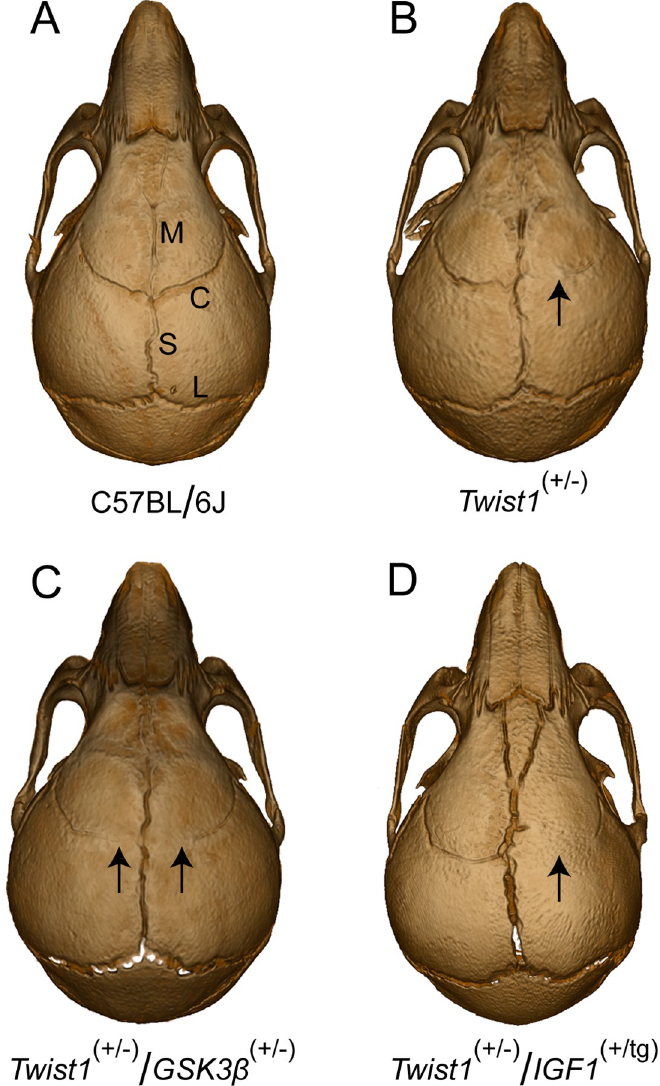
Fig 2. MicroCT images of representative P28 skulls. (A) wildtype C57BL/6J mouse with normal calvarial suture pattern, (B) Twist1 (+/-) mouse with right coronal craniosynostosis, (C) Twist1 (+/-) / Gsk3 β (+/-) mouse with partial bilateral coronal craniosynostosis, and (D) Twist1 (+/-) / Igf1 (+/tg) mouse with right coronal craniosynostosis. Sutures are labelled as follows: M (metopic or interfrontal), C (coronal), S (sagittal), and L (lambdoid). Arrows designate areas of premature suture